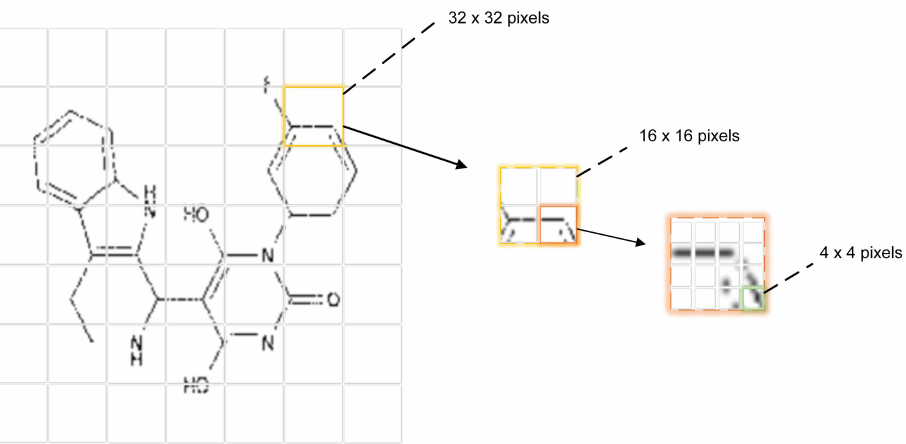
Figure 3. Processing of three levels of